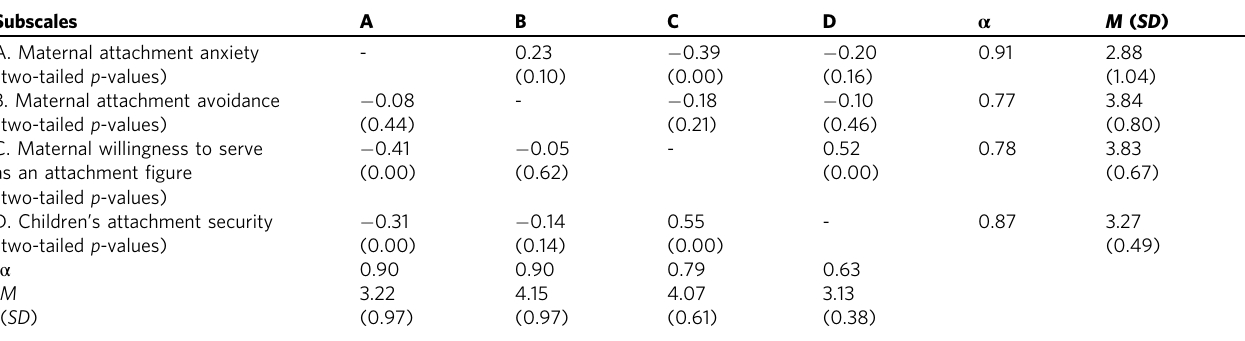
Table 1 Summary of descriptive statistics and Pearson product-moment correlation coef fi cients in Samples 1 and 2. Subscales